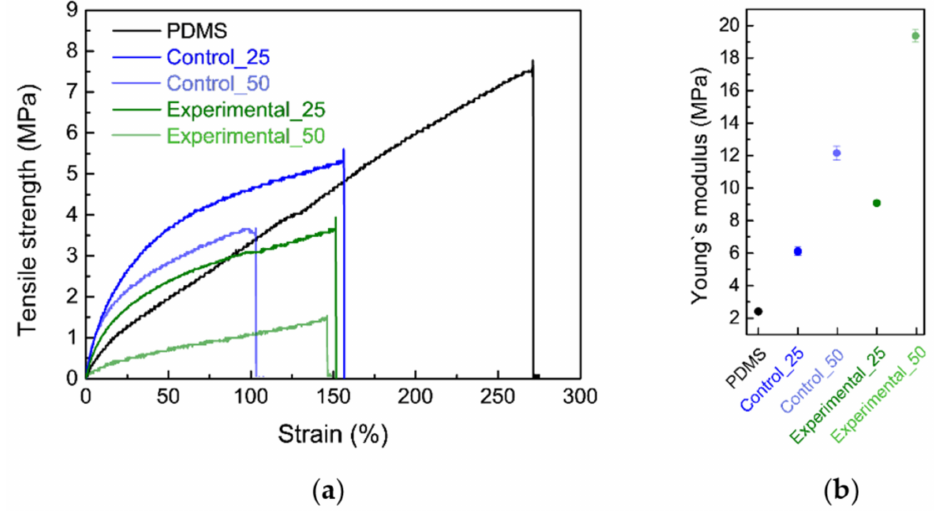
Figure 1. Tensile stress-strain curves ( a ) and Young’s modulus ( b ) of di ff erent bioelastomers (PDMS, Control_25, Control_50, Experimental_25, and Experimental_50).